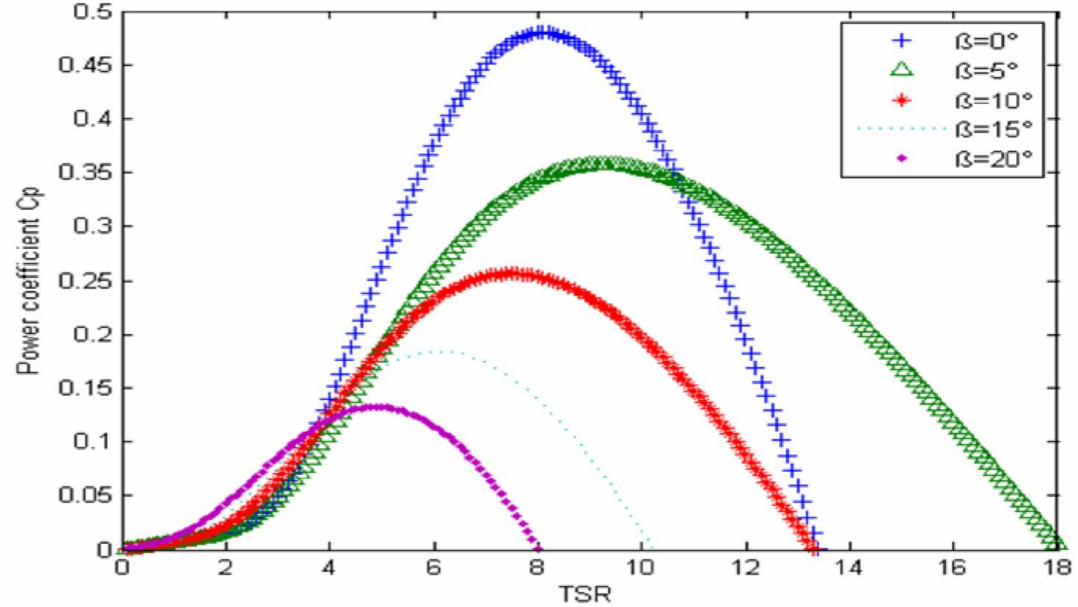
Figure 17. The effect of the tip speed ratio TSR ( λ ) on the power coefficient at a different pitch angle [103].